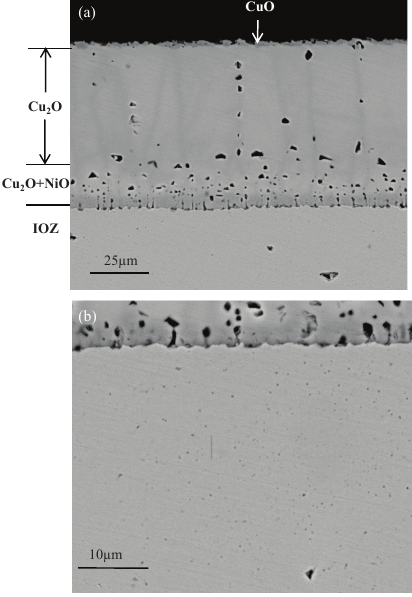
Figure 5. BEI micrographs of a cross section of Cu-2Ni oxidized at 800 °C in 1 atm O 2 for 30 min. (a) General view; (b) Enlarged view of the